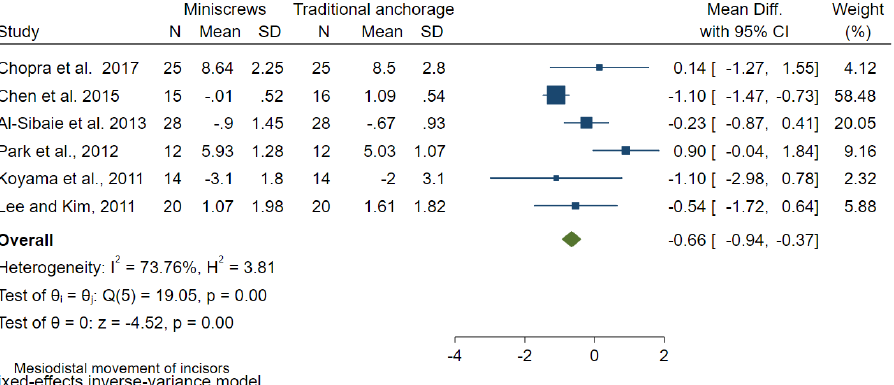
Figure 2. The Forest plot showed the Mesiodistal movement of incisors between miniscrews vs. traditional